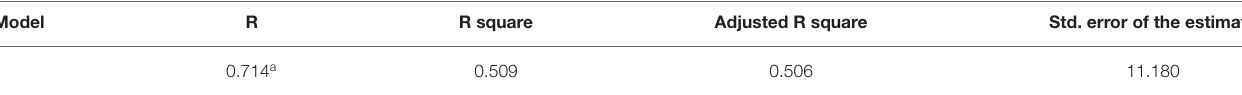
TABLE 4 | Model summary for work engagement, emotional intelligence and ambiguity tolerance.